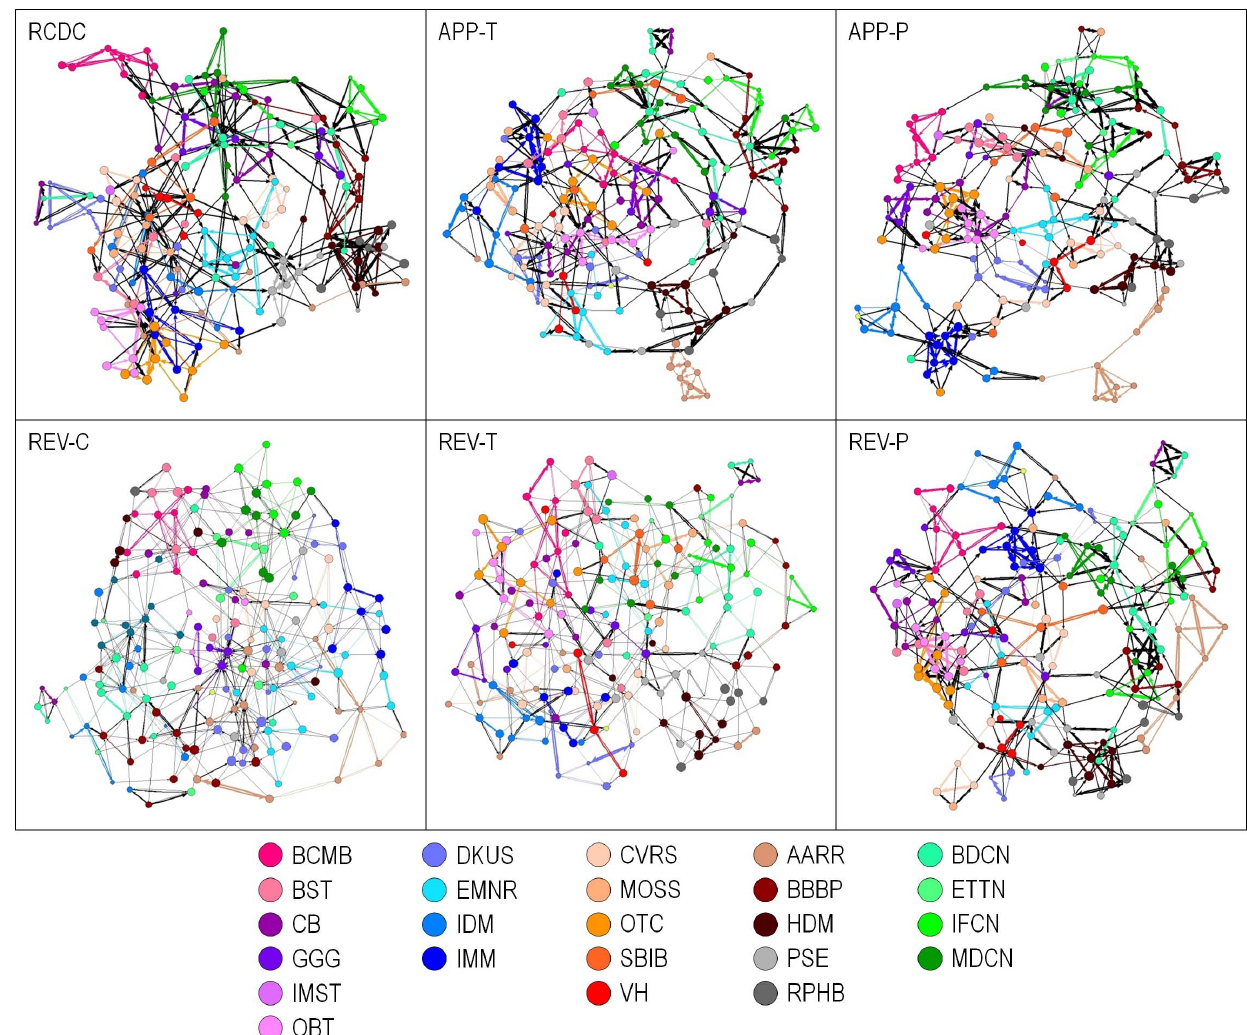
Figure 2. Study section networks generated using six different features associated with SRGs. Edges between SRGs within the same IRG are colored with the IRG color. Edges between study sections in different IRGs are colored black. Arrows point from the choosing study section to the chosen study section. Links with arrows on both ends denote that each study section is in the top 3 list of the paired study section.